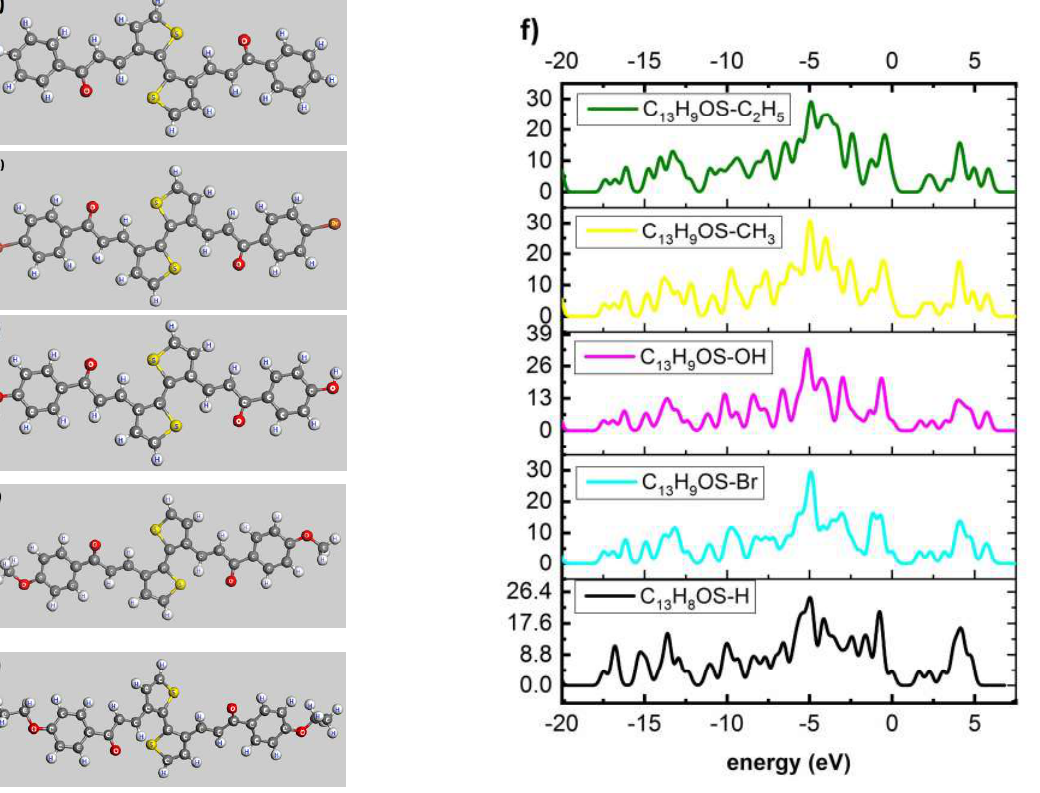
Figure 5. The structural shapes of C 13 H 8 OS–H ( a ), C 13 H 8 OS–Br ( b ), C 13 H 8 OS–OH ( c ), C 13 H 8 OS–OCH